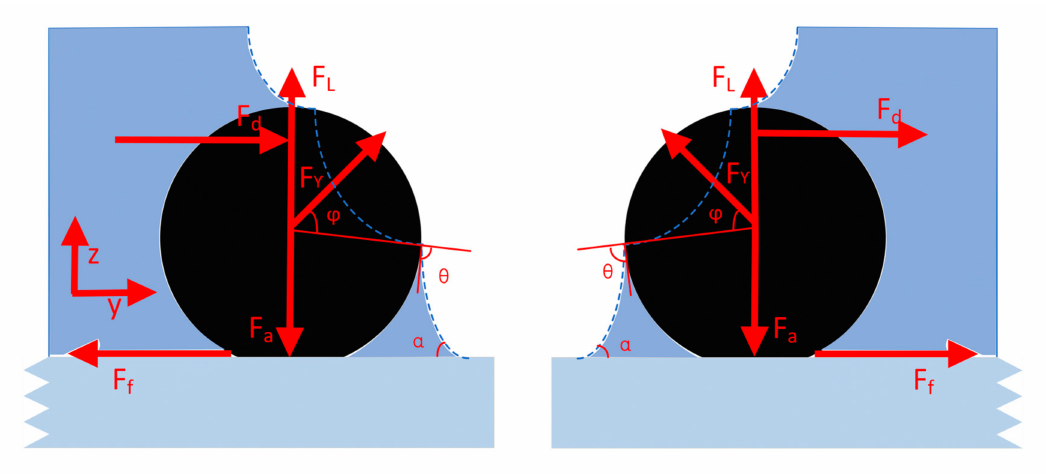
Figure 3. The force on the particle when it encounters the gas–liquid